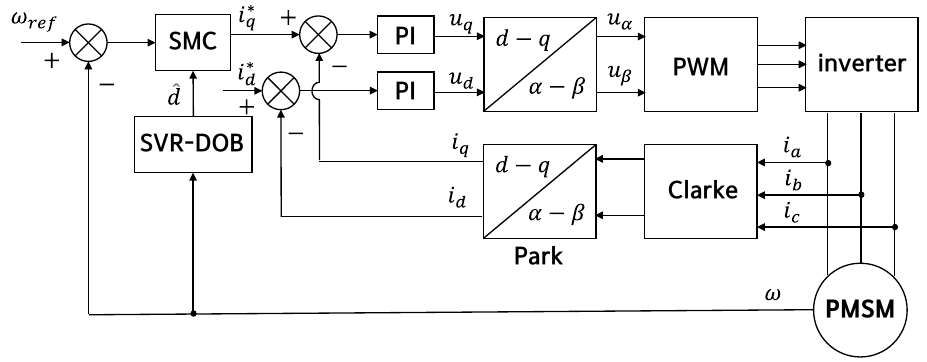
Figure 1. SMC with SVR-DOB of a